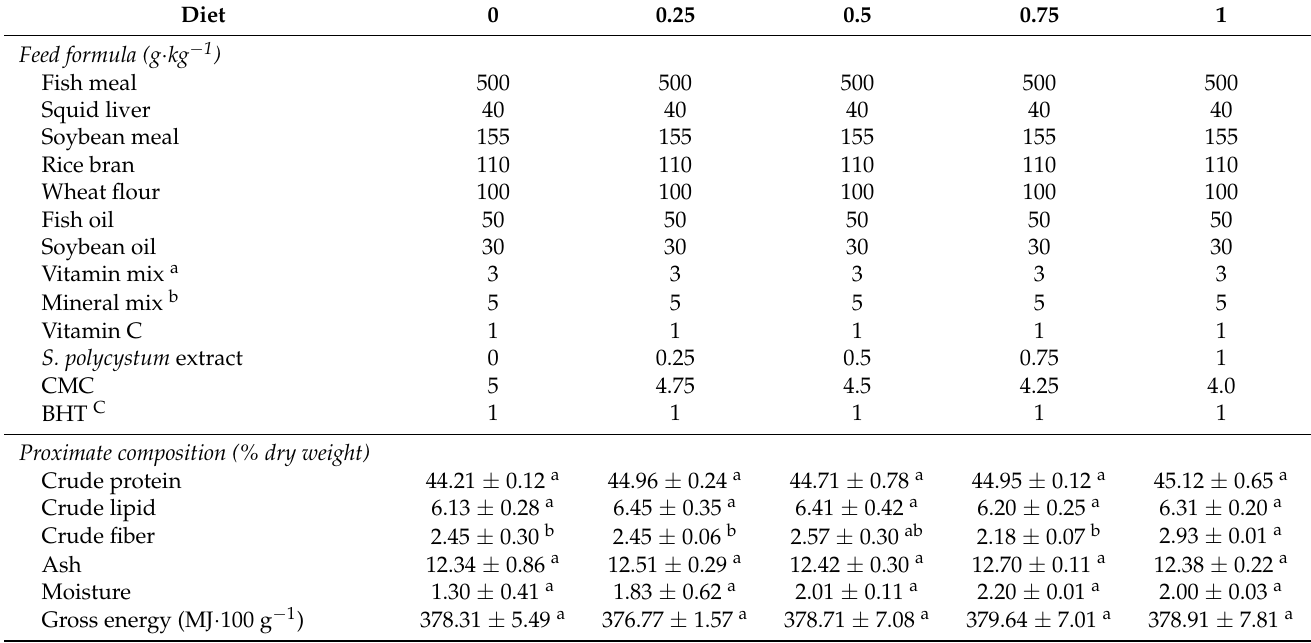
Table 2. Formulation and proximate composition of experimental